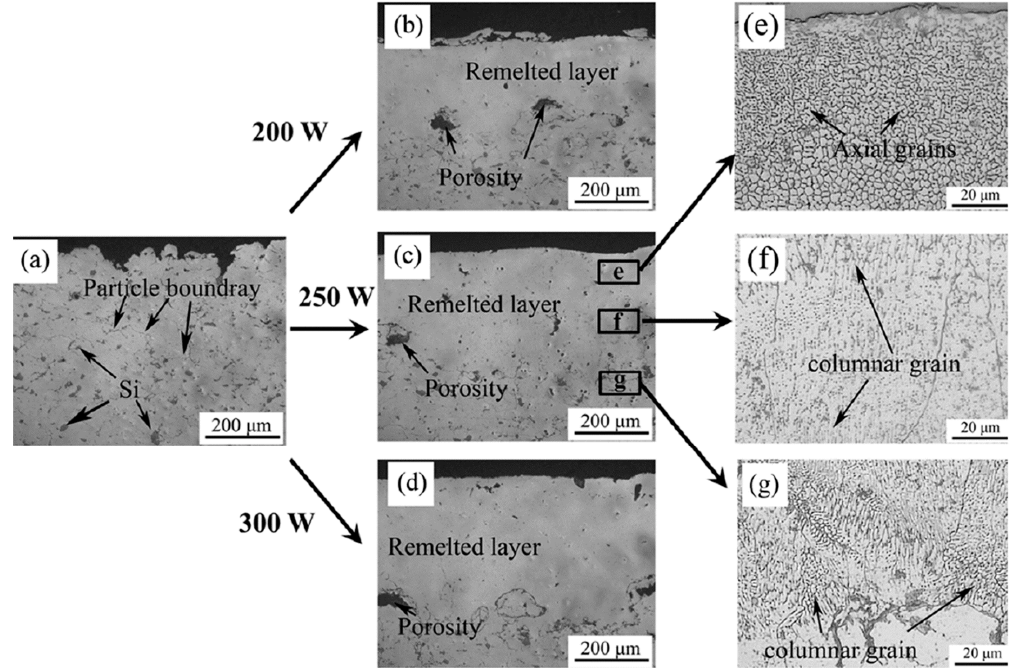
Figure 19. ( a – d ) Cross-section views of ( a ) as-sprayed Al-Si and ( b , c and d ) same sample after laser surface re-melting at 200, 250 and 300 W, respectively, and ( e , f and g ) microstructures corresponding to the respective top, middle and bottom portions of the sample shown in ( c ) (adapted from reference [86], with permission from © Elsevier).